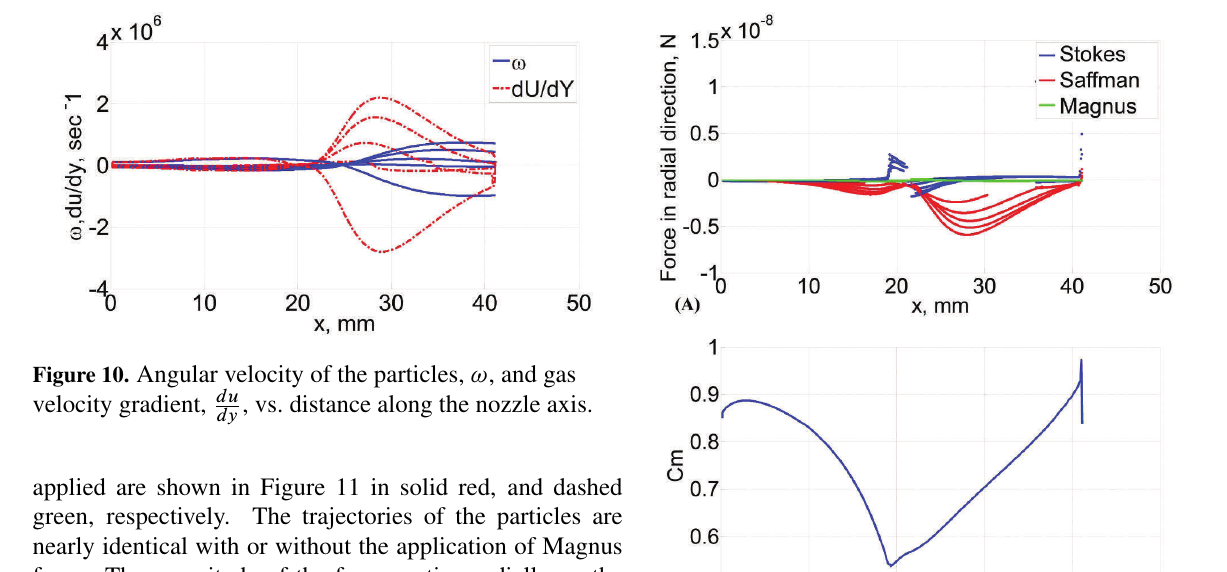
tant trajectories of those 6 µm particles with (dashed